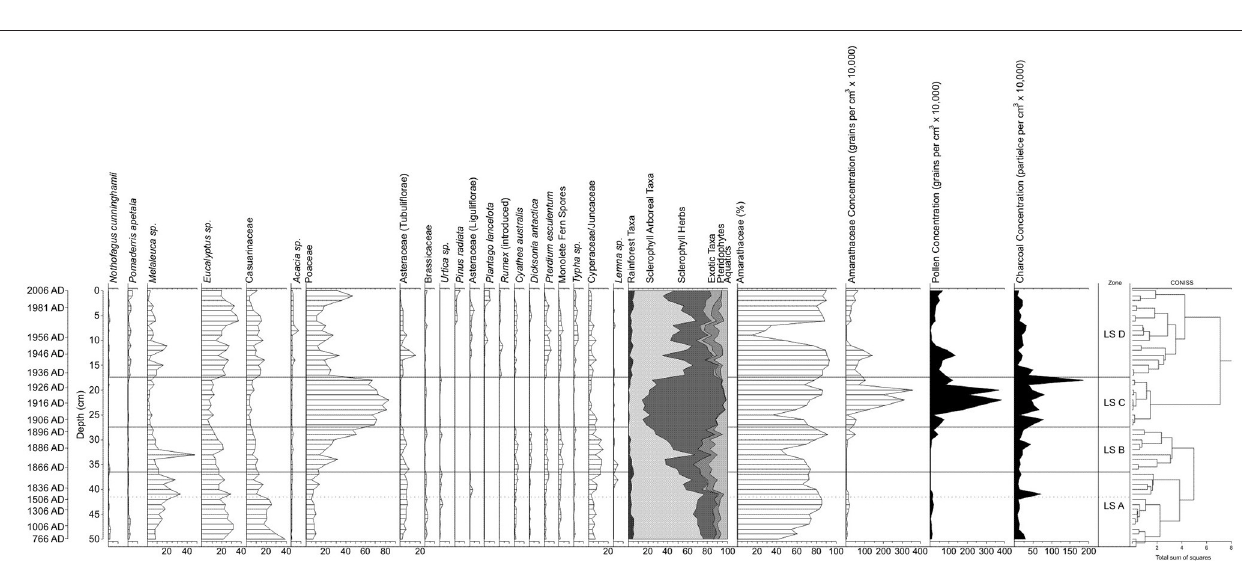
FIGURE 3 | Little Swanport salt-marsh pollen diagram. Ages are shown in calendar years (AD), the hashed line marks the occurrence of exotic pollen, as well as the hiatus in sedimentation between ∼ 1500 and 1830 AD, and the solid line marks the zone boundaries (based on the CONISS cluster analysis). Pollen taxa with < 2.5% are not shown on the diagram and include rainforest trees ( Dacrydium franklinii , Podocarpus lawrencei , and Phyllocladus aspleniifolius ); sclerophyll arboreal taxa ( Callitris sp., Beyeria sp., Dodonaea sp., Monotoca sp., Ericaceae, Banksia marginata , Protaceae, and Coprosma sp.); sclerophyll shrubs/herbs (Rubiaceae, Fabaceae, and Rutaceae); sclerophyll herbs ( Plantago sp. (native) , Rumex sp. (native) , Acaena sp., Apiaceae, and Liliaceae ); exotic taxa ( Salix sp.); Pteridophytes ( Lycopodium sp., Histiopteris sp., and Sphagnum sp.); and aquatic taxa (Restionaceae, Potamegeton sp., Triglochin sp., Persicaria prostrata , Myriophyllum sp., and Nymphoides